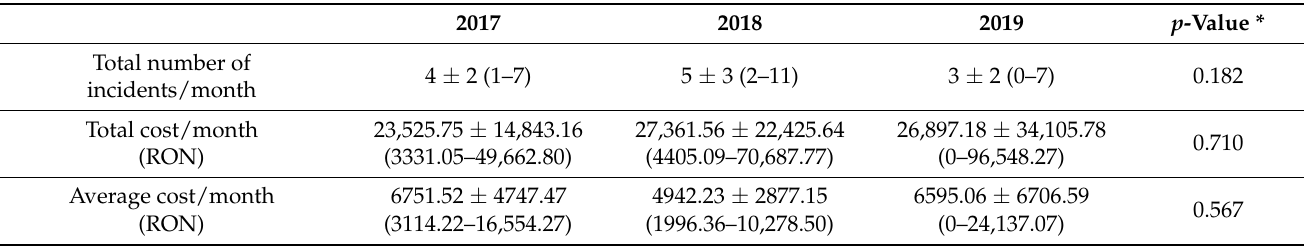
Table 2. Descriptive statistics and p -value for number of incidents, total cost/month, and average cost/month.